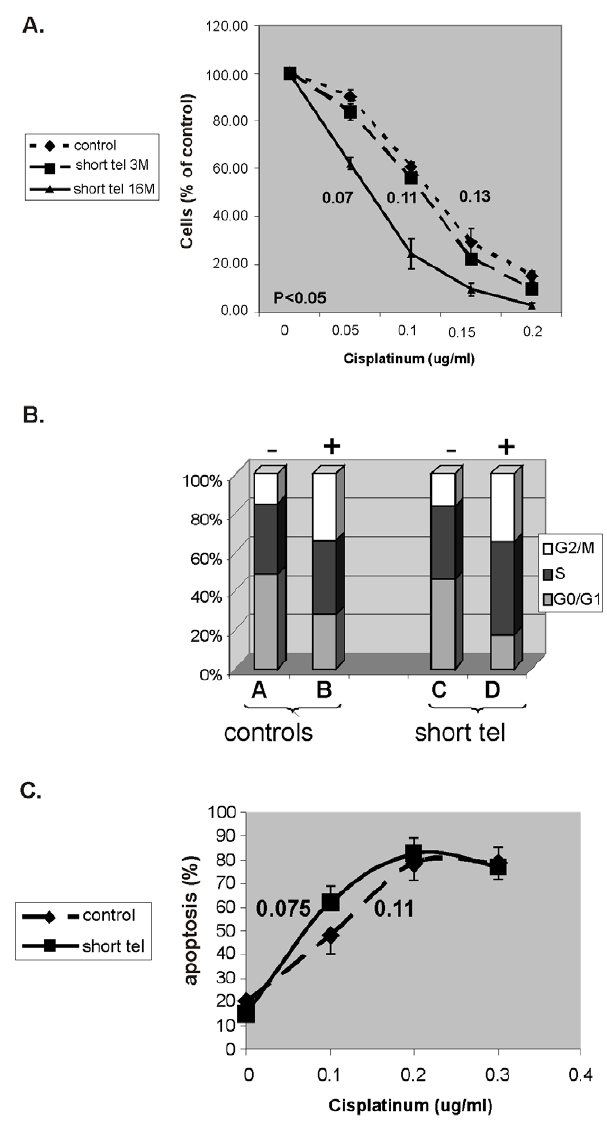
Figure 2. Sensitivity of SK-N-MC cells to cisplatinum is telomere length dependent. a. Proliferation of cells with shortened telomeres exposed to cisplatinum. SK-N-MC cells were continuously exposed to GRN163. The sensitivity of the cells to cisplatinum was estimated after three and 16 months of telomerase inhibition. Numbers indicate the IC 50 of the drug in these time points (after 22% and 40% reduction in telomere length). P value refers to difference between WT and short tel-16 months. b. Cell cycle status of SK-N-MC cells with shortened telomeres exposed to 0.13 m g/ml cisplatinum. SK-N-MC cells with shortened telomeres were exposed to cisplatinum and the cell cycle status was evaluated by FACS. + or 2 refers to the exposure to cisplatinum. C. The apoptotic index of SK-N-MC cells with shortened telomeres exposed to cisplatinum. The same cells were analyzed by FACS for their apoptotic index, as represented by their preG1 status. The numbers indicate the LD 50 of cisplatinum in cells with intact or shortened